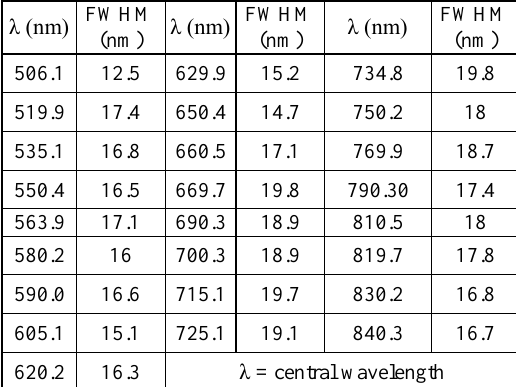
Figure 1: Spectral response of soils Adapted from McCoy, 2005